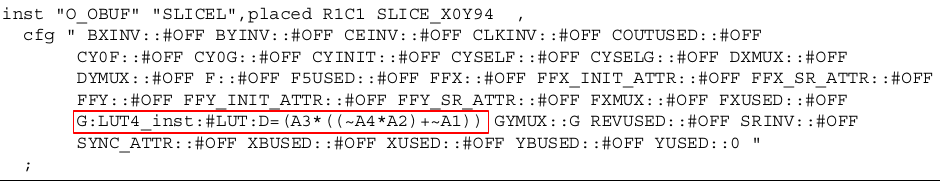
Figure 5. Example of XDL in Spartan-3.